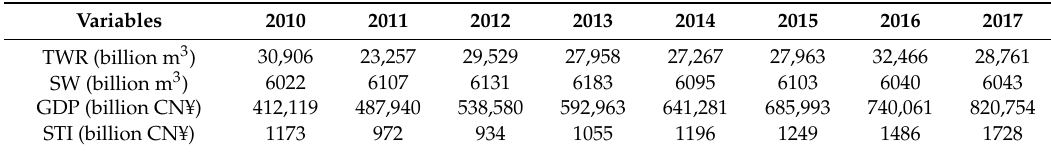
Table 1. China’s total water resources (TWR), total water supply (SW) and gross domestic product (GDP) in periods